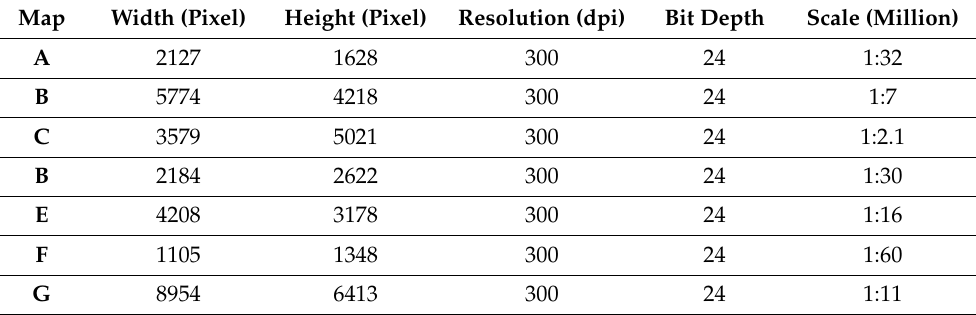
Table 1. Dataset